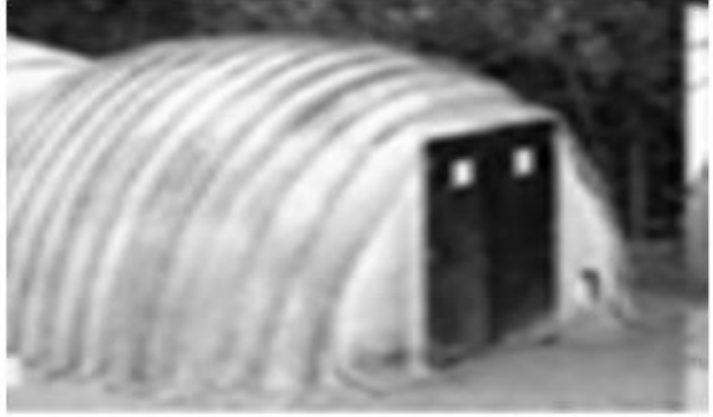
Figure 7. Abacterial cement tents (Leydecker ,